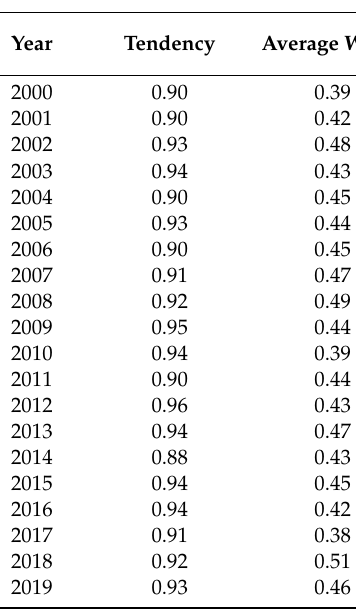
Table 2. Cluster tendency and silhouette width for the optimal number of clusters for each year based on 5000 random